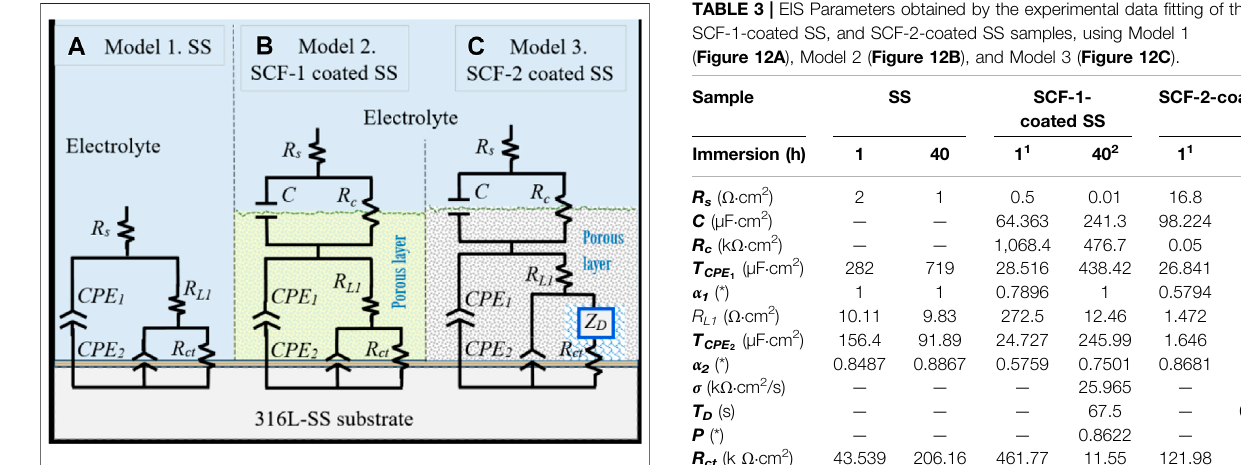
FIGURE 12 | Equivalent circuit models of the corrosion mechanisms observed at theactive interfaces. Model 1for uncoated substrate, Model 2for BG-PLAcoatings. (A) Model1,SS. (B) Model2,SCF-1-coatedSS. (C) Model 3, SCT-2-coated SS.